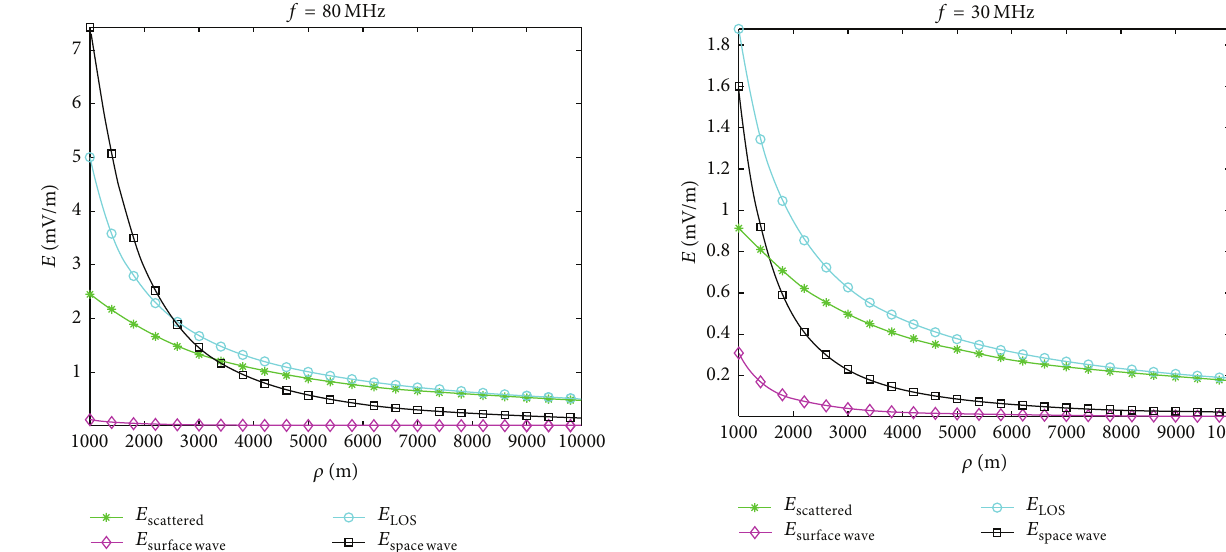
Figure 3: Electric fields at observation point as a function of horizontal distance 𝜌 between transmitting Hertzian dipole and observation point, for frequency 𝑓 = 80 MHz. Here, the various components of received electric field are shown as follows: line- of-sight (LOS) field (circle), field scattered from ground (asterisk), “space wave” (square), and “surface wave” (diamond). Note that in this case Norton’s “surface wave” is rather negligible as compared to the corresponding “space wave” [15].